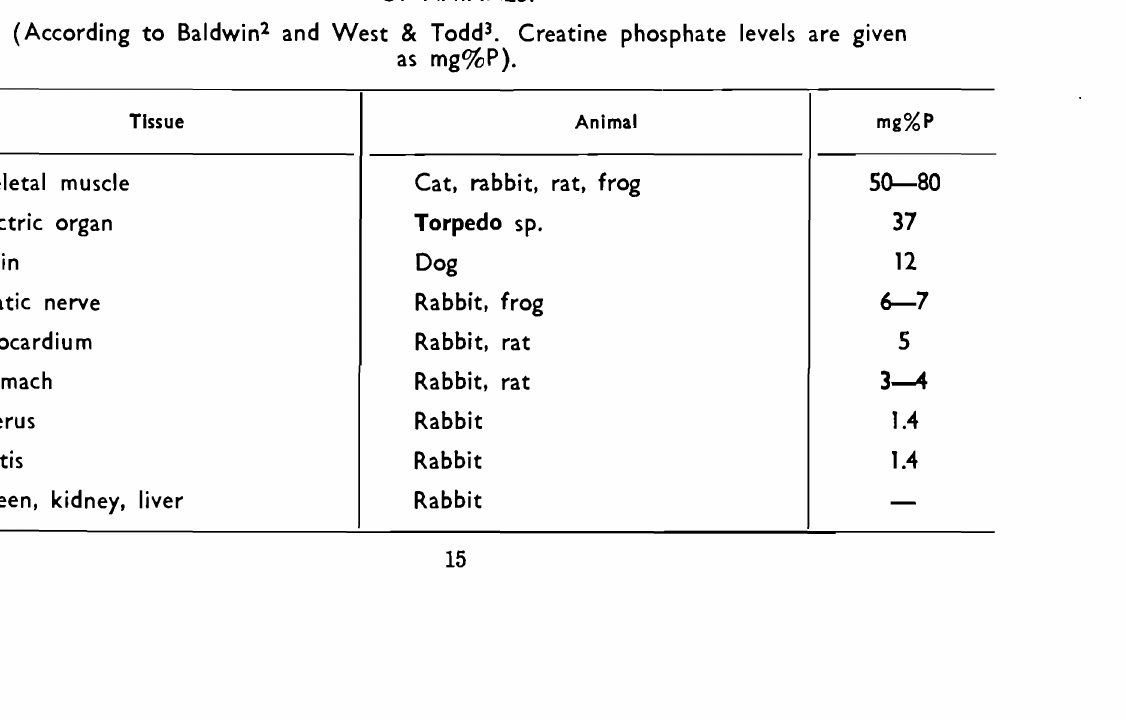
Table 2: DISTRIBUTION OF CREATINE PHOSPHATE IN THE BODY TISSUES OF